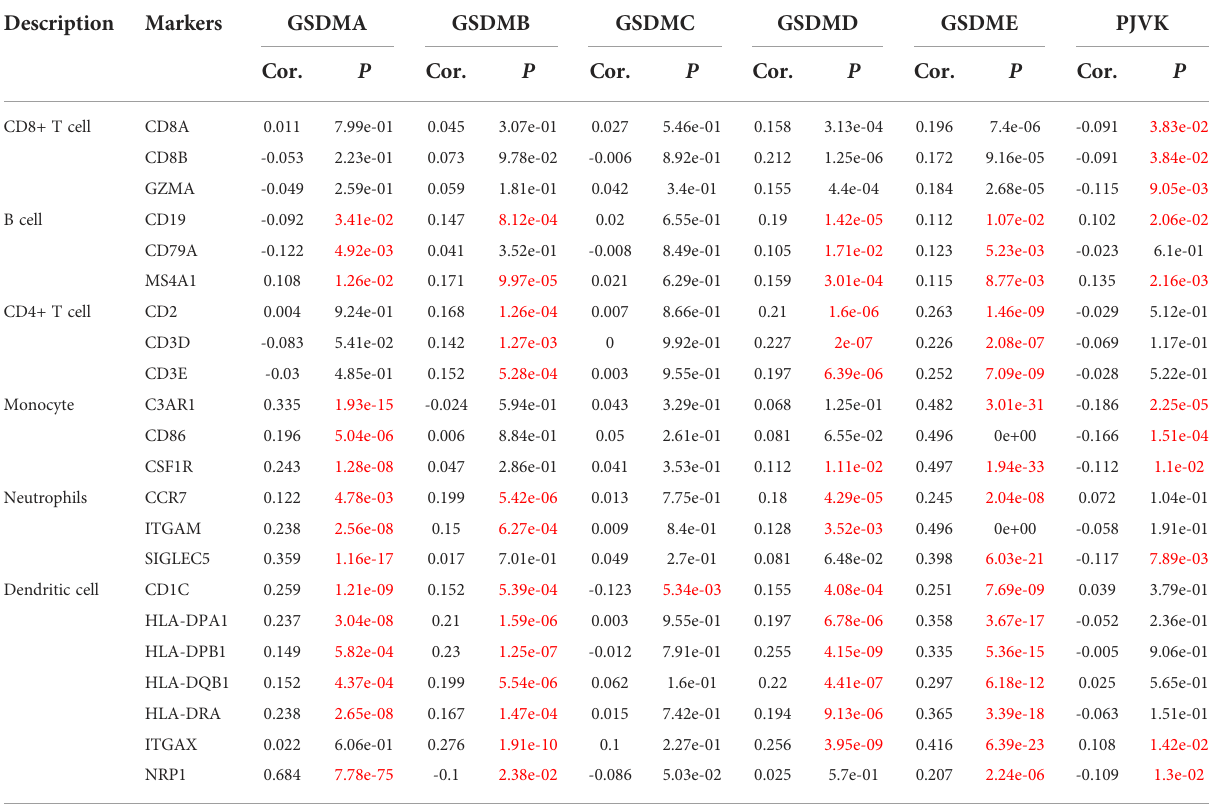
TABLE 1 Association between the expression of GSDM family members and the markers of immune cells. Description